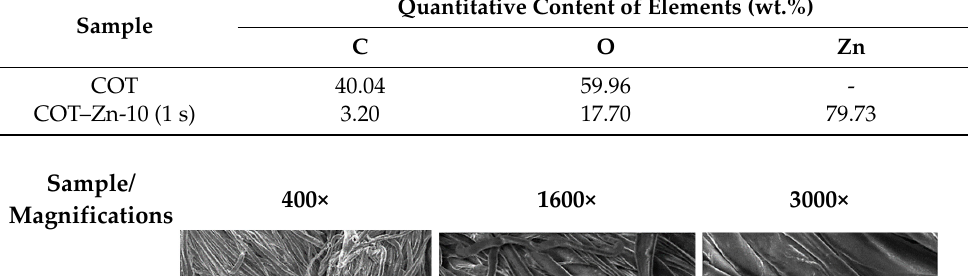
Figure 1. SEM results (magnifications: X400, X1600, and X3000) of the tested samples recorded be- fore and after magnetron sputtering with a zinc target.